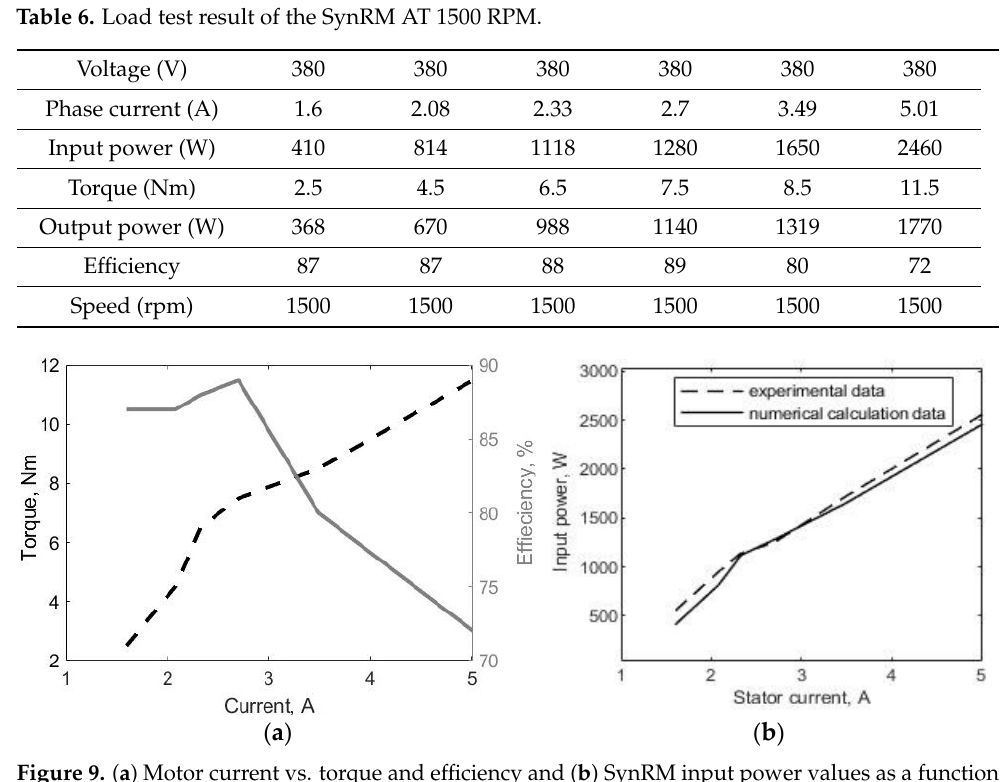
Figure 9. ( a ) Motor current vs. torque and efficiency and ( b ) SynRM input power values as a function of motor stator current for the case of 1500 rpm. Table 5 . N o -l oad test result of the S yn RM.